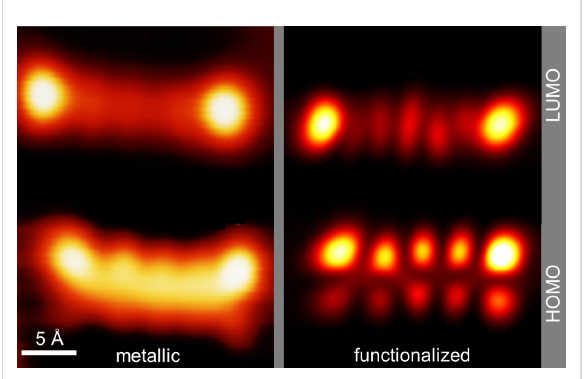
Figure 4: Spatial mapping of the molecular orbitals of pentacene by employing an STM tip without (left) and with (right) pentacene functio- nalization ( U (LUMO) = +1.2 V, U (HOMO) = − 2.1 V, I = 50 pA, con- stant height).